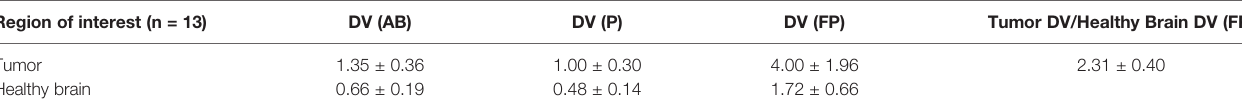
TABLE 2 | Logan plot [ 18 F]FGln pharmacokinetic (reversible uptake model) result summary. Region of interest (n = 13)